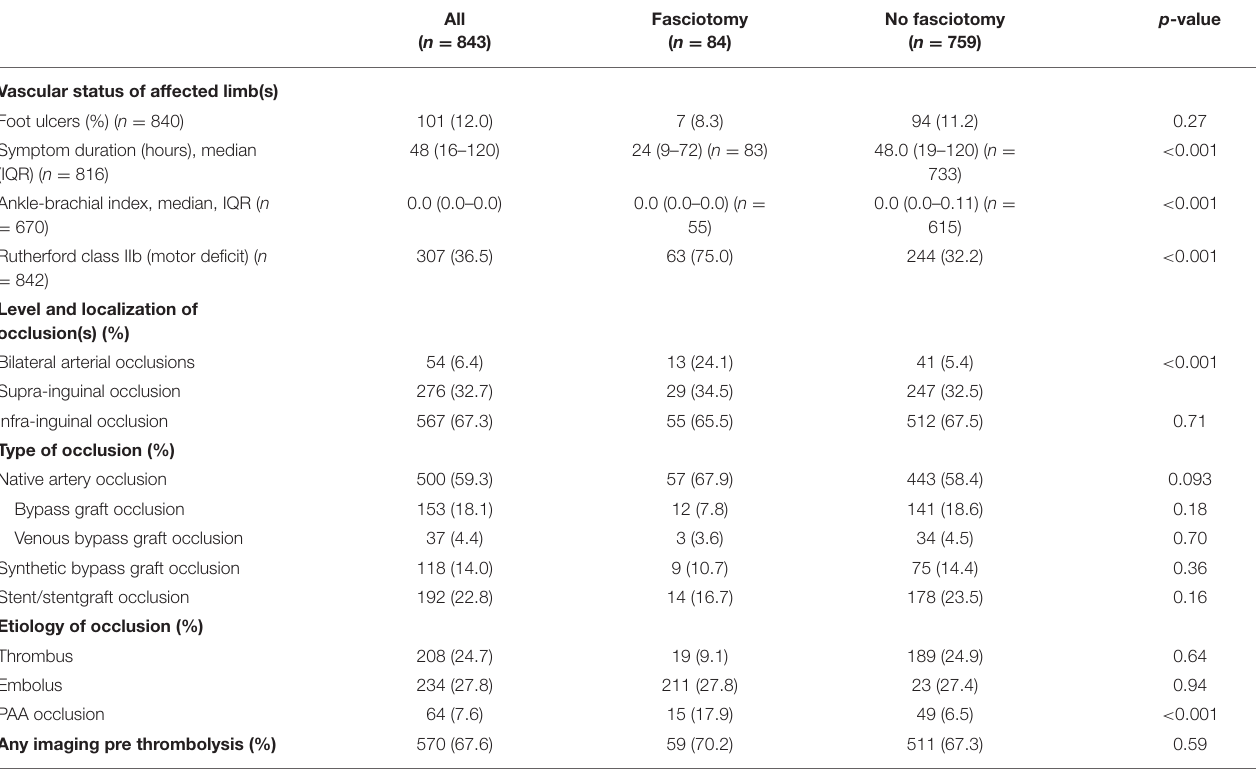
TABLE 2 | Diagnostic assessment at admission in patients undergoing fasciotomy or not after reperfusion for ALI.